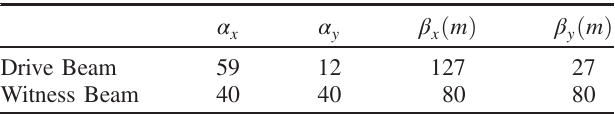
TABLE II. The Twiss parameters of both beams at the exit of the final focusing